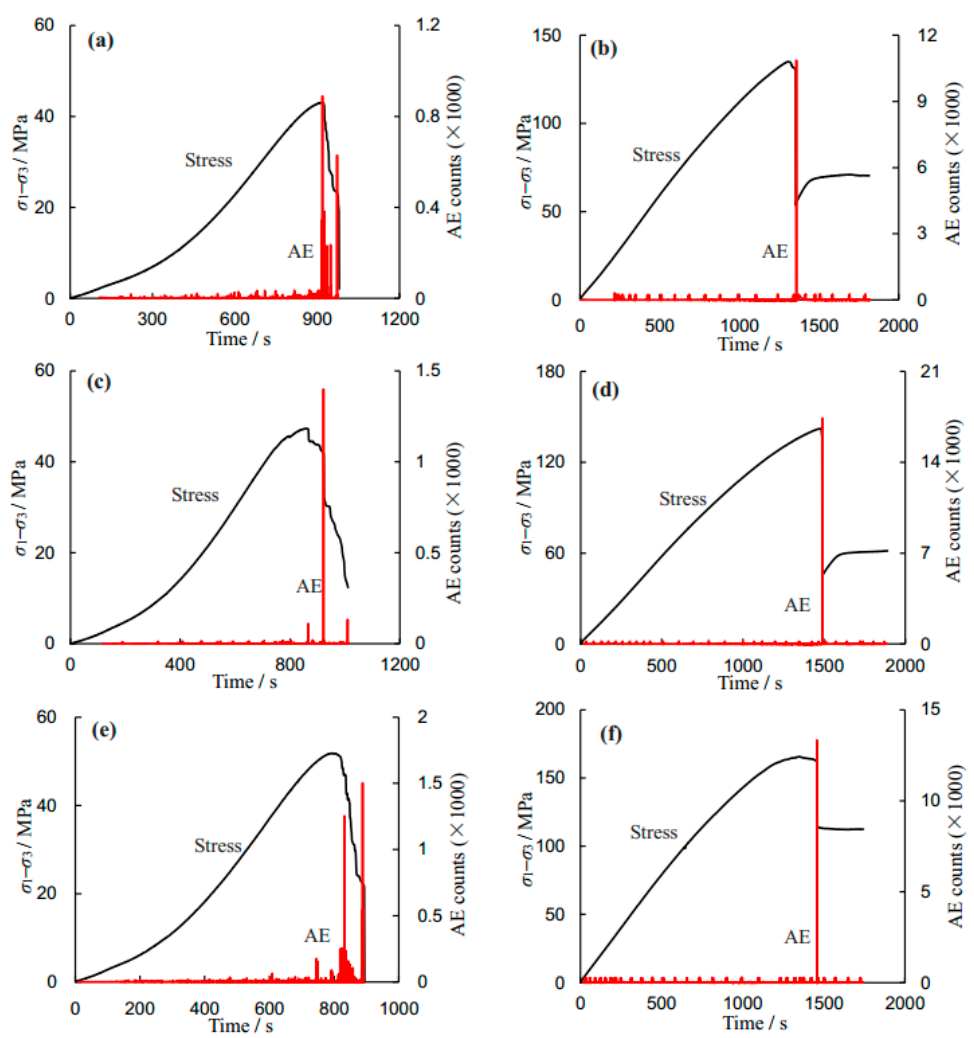
Figure 13. AE counts and accumulated AE counts of saturated sandstone specimens during the whole deformation process. ( a ) Water, σ 3 = 0 MPa; ( b ) Water, σ 3 = 40 MPa; ( c ) 10% NaCl, σ 3 = 0 MPa; ( d ) 10% NaCl, σ 3 = 40 MPa; ( e ) 30% NaCl, σ 3 = 0 MPa; and ( f ) 30% NaCl, σ 3 = 40 MPa.